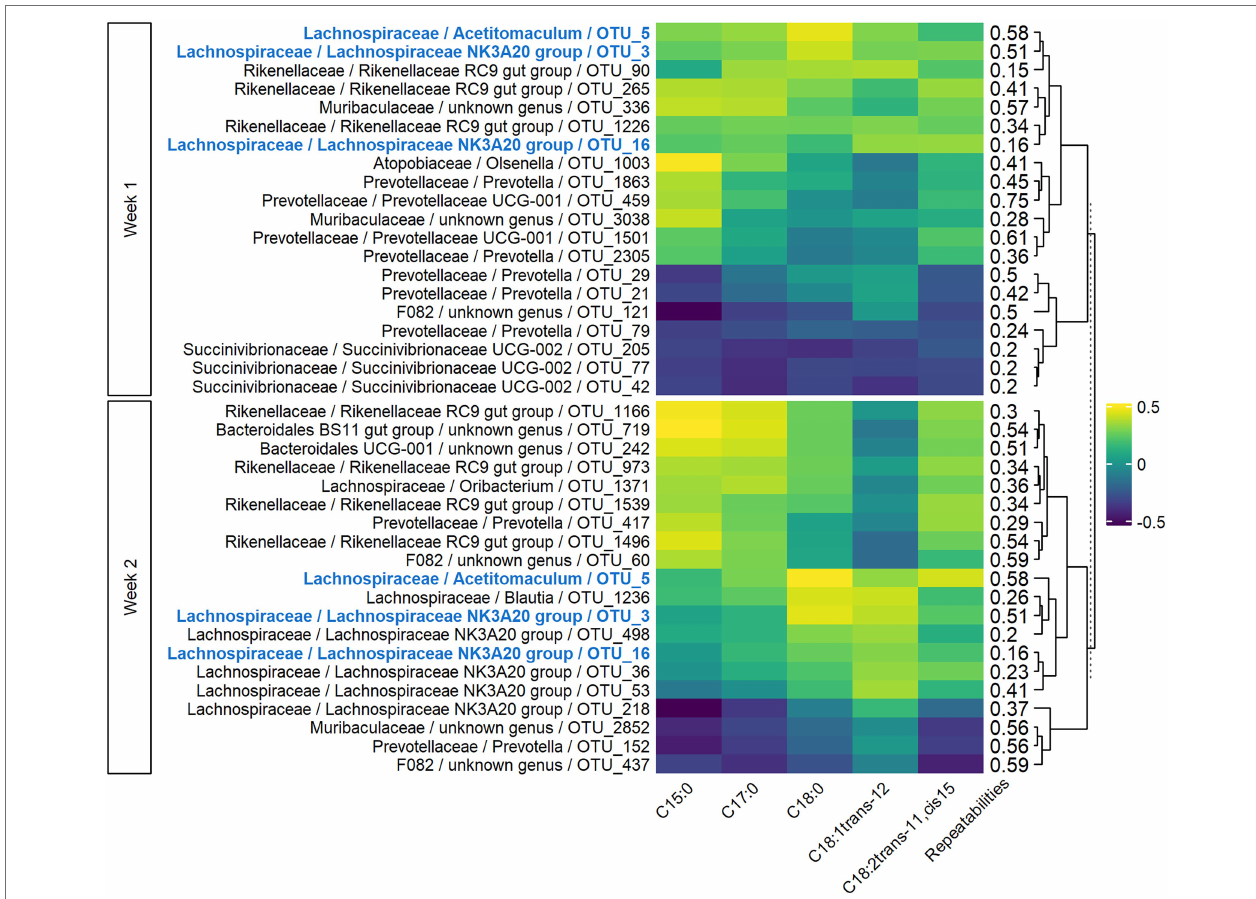
FIGURE 4 | Pearson correlations between bacterial OTUs and rumen long-chain fatty acids on both weeks of sampling. Only the 20 more correlated OTUs and rumen LCFAs having at least one significant correlation in both weeks with them were presented. In bold and blue, OTUs conserved from week 1 to week